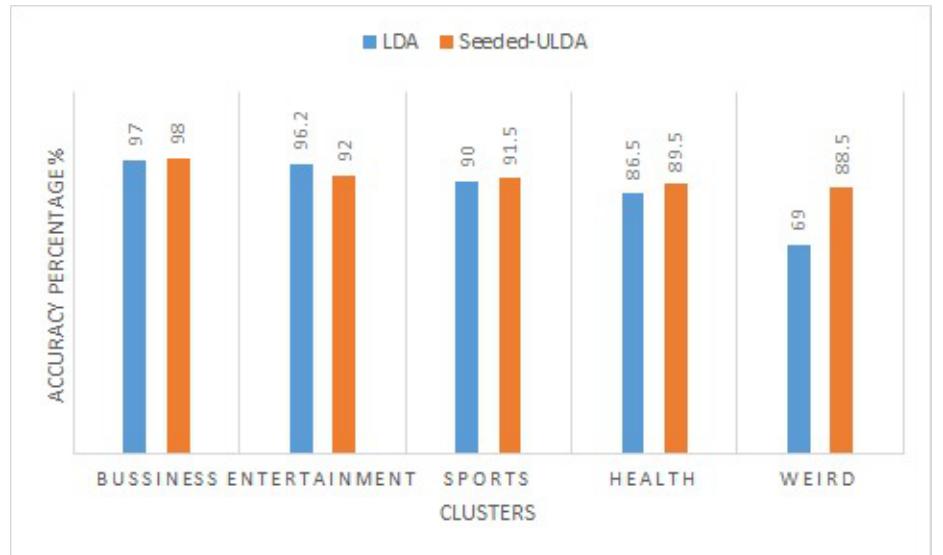
Figure 8. Accuracy of of Seeded-ULDA and LDA on dataset with overlapping.